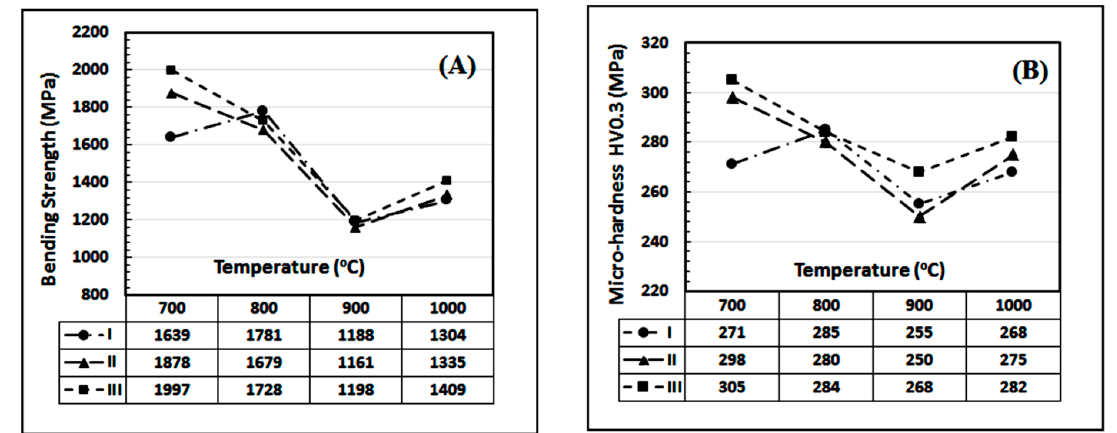
Figure 8. Impact of pre-treatments and sintering temperatures on ( A ) bending strength and ( B ) microhardness of sintered pellets.